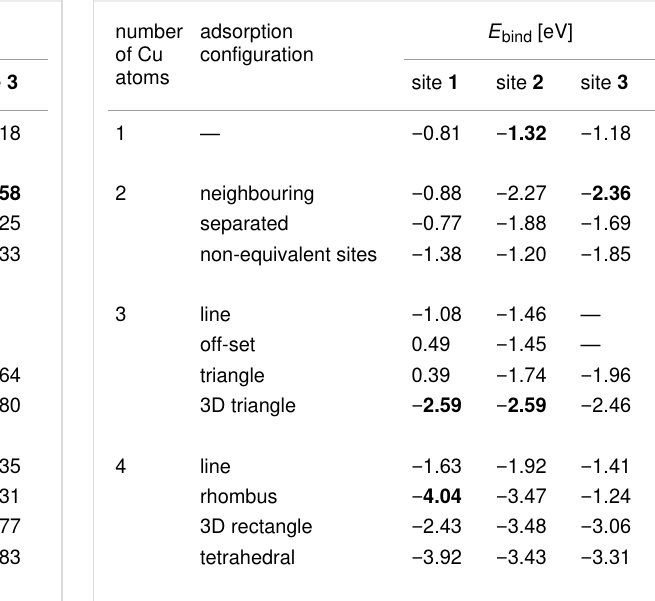
Table 2: Computed binding energies for Cu 1 , Cu 2 , Cu 3 and Cu 4 on MoS 2 for different atom configurations from Equation 2. For the “non- equivalent” configurations of Cu 2 , the column “site 1 ” has atoms at sites 1 and 2 , “site 2 ” has atoms at 1 and 3 and “site 3 ” has atoms at 2 and 3